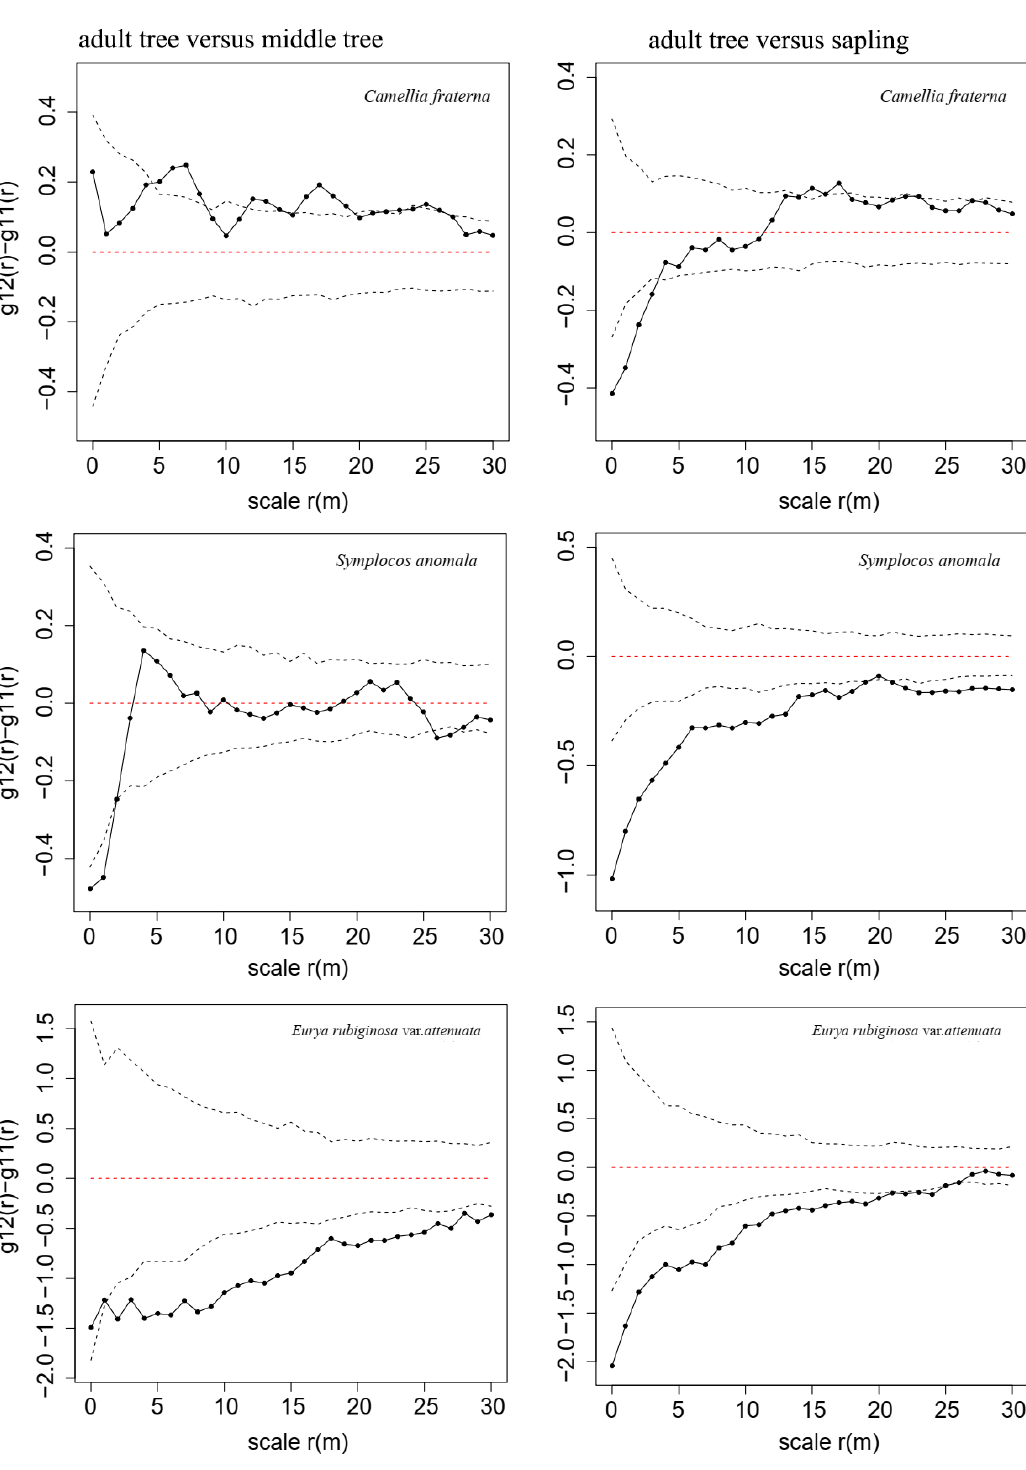
Figure 6. Juvenile–adult ( left ) and sapling–adult ( right ) association analyses of Camellia fraterna , Symplocos anomala , and Eurya rubiginosa var. attenuata with a random labelling case–control design. Comparisons between saplings and adults of Camellia fraterna revealed greater sapling aggregation at 0–3.5 m scales, greater uniformity on some intermediate scales, but generally, randomness at most scales. In Symplocos anomala , saplings were more aggregated than adults on most scales, and only randomly distributed at the 20 m scale. Similarly, Eurya rubiginosa var. attenuate saplings were more aggregated than adults at 0–25 m scales but otherwise random. Rhododendron ovatum saplings were more aggregated than